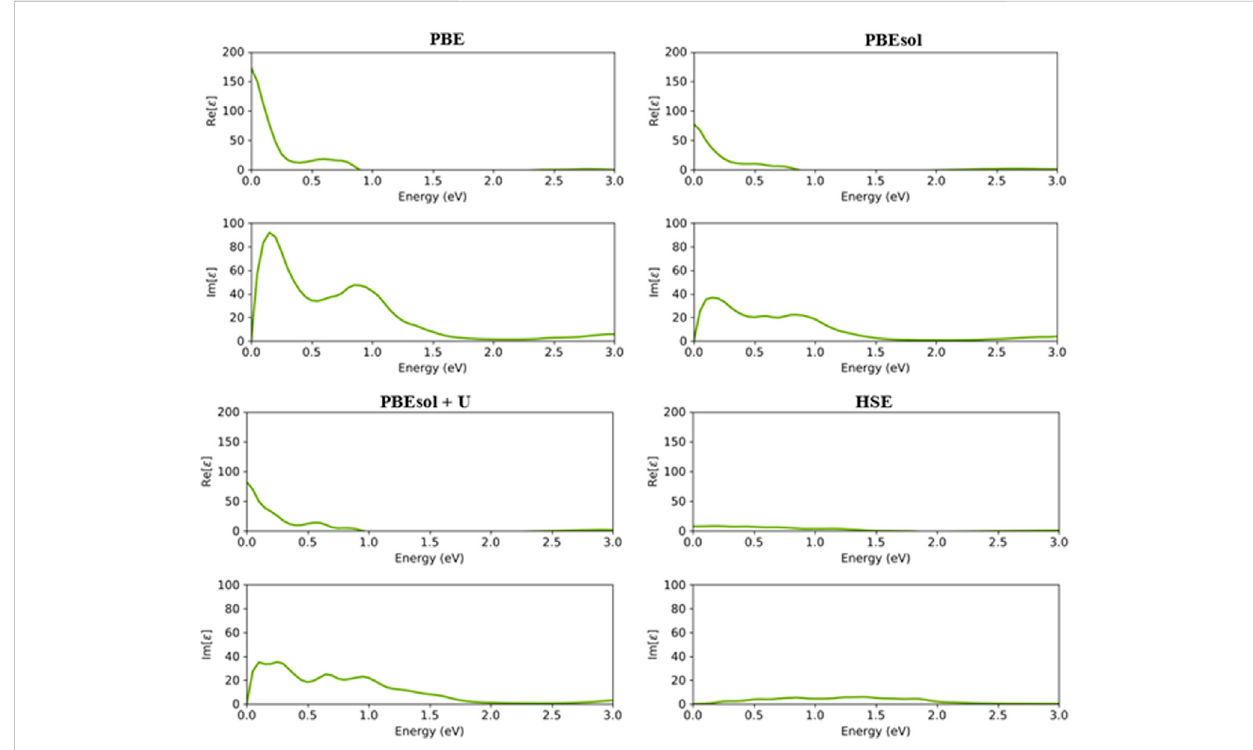
FIGURE 5 RealandimaginarypartsofthedielectricconstantsoftheVO 2 (M)polymorphasafunctionoftheenergy(eV),predictedbythePBE,PBEsol,PBEsol+ U, and HSE